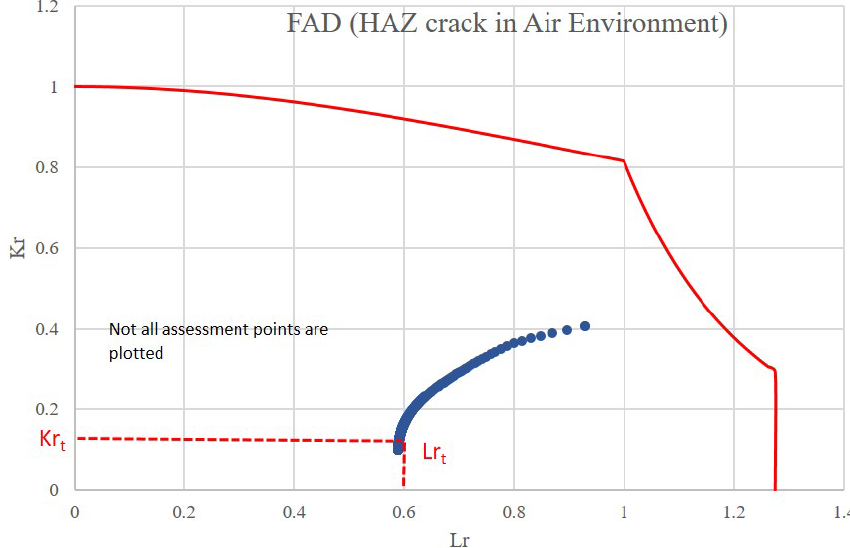
Figure 20. Failure assessment diagram (FAD) for crack growth in HAZ and in air environment without inspection.